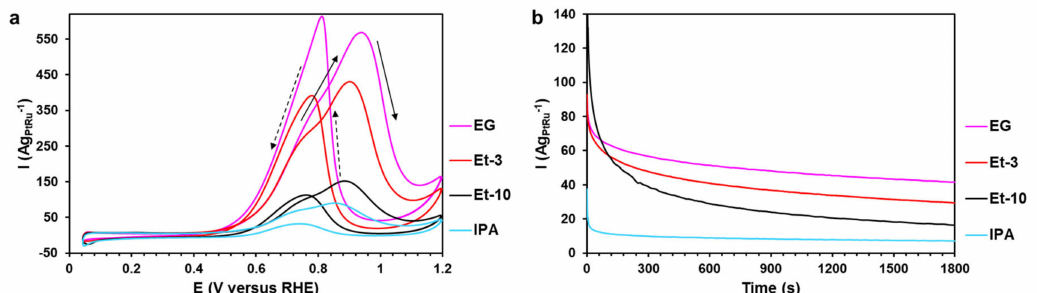
Figure 4. ( a ) Cyclic voltammograms of the PtRu/C materials. The potential sweep rate is 20 mVs − 1 . The electrolyte is 0.5 M CH 3 OH + 0.1 M HClO 4 saturated with Ar under atmospheric pressure. ( b ) Chronoamperograms at 0.6 V for 1800 s of the PtRu/C bimetallic alloys in the 0.5 M CH 3 OH + 0.1 M HClO 4